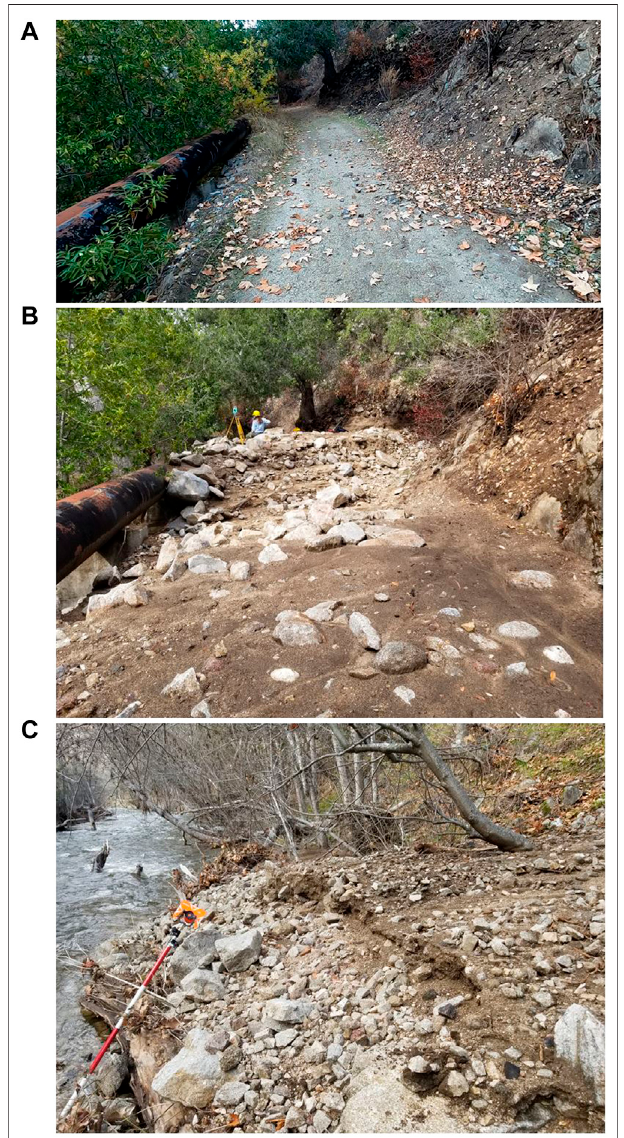
FIGURE 9 | Debris fl ow from basin seven ( Figure 4 ; Table 2 ). (A) road and pipeline at toe of slope before debris fl ow. (B) Same view after debris fl ow (personandtotalstationforscale). (C) Debris fl owsnouterodedbyhighwater following January 27 storm runoff (1.5 m range pole for scale).